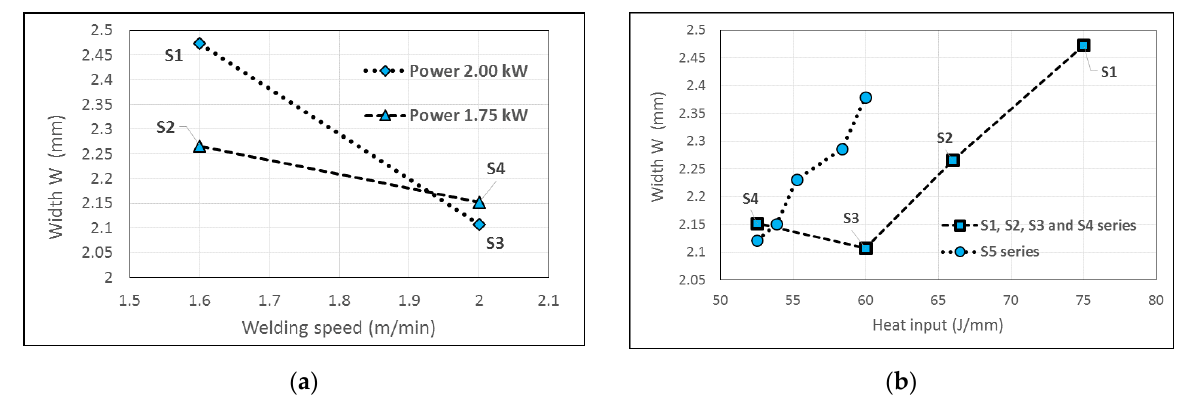
Figure 11. ( a ) Interaction in the factorial experiment; ( b ) width W in the function of the Heat